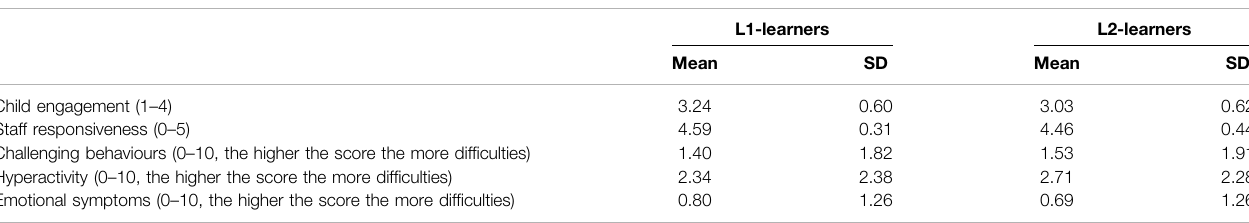
TABLE 2 | Means and standard deviation between groups.